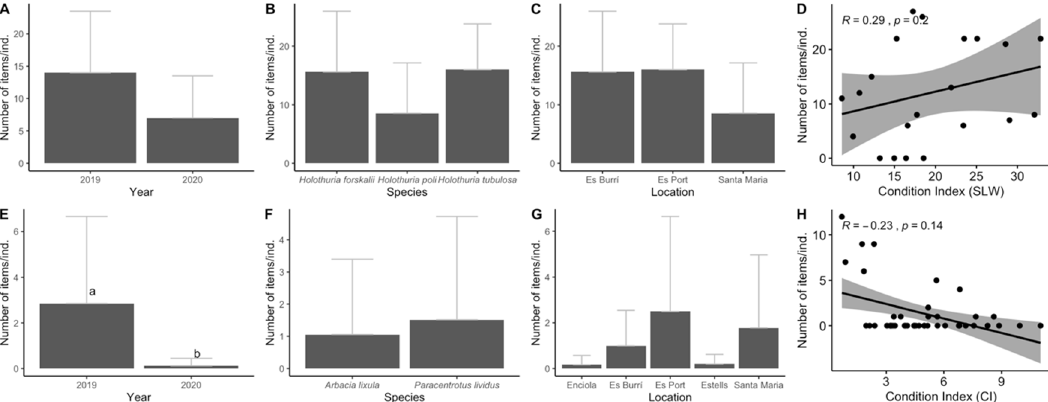
Figure 5. Results for the ingestion of anthropogenic particles (APs) in echinoderm samples for sea cucumbers (Holothuria sp.): year ( A ), species ( B ), location ( C ) and square root of the length–width index (SLW) ( D ) and for sea urchins: year ( E ), species ( F ), and location ( G ) as well as the Spearman’s rank correlation (significance level at p = 0.05) between Condition Index (CI) ( H ). The error bars indicate a 95% confidence interval, and significant differences are indicated by different letters. The significance level was established at p < 0.05.